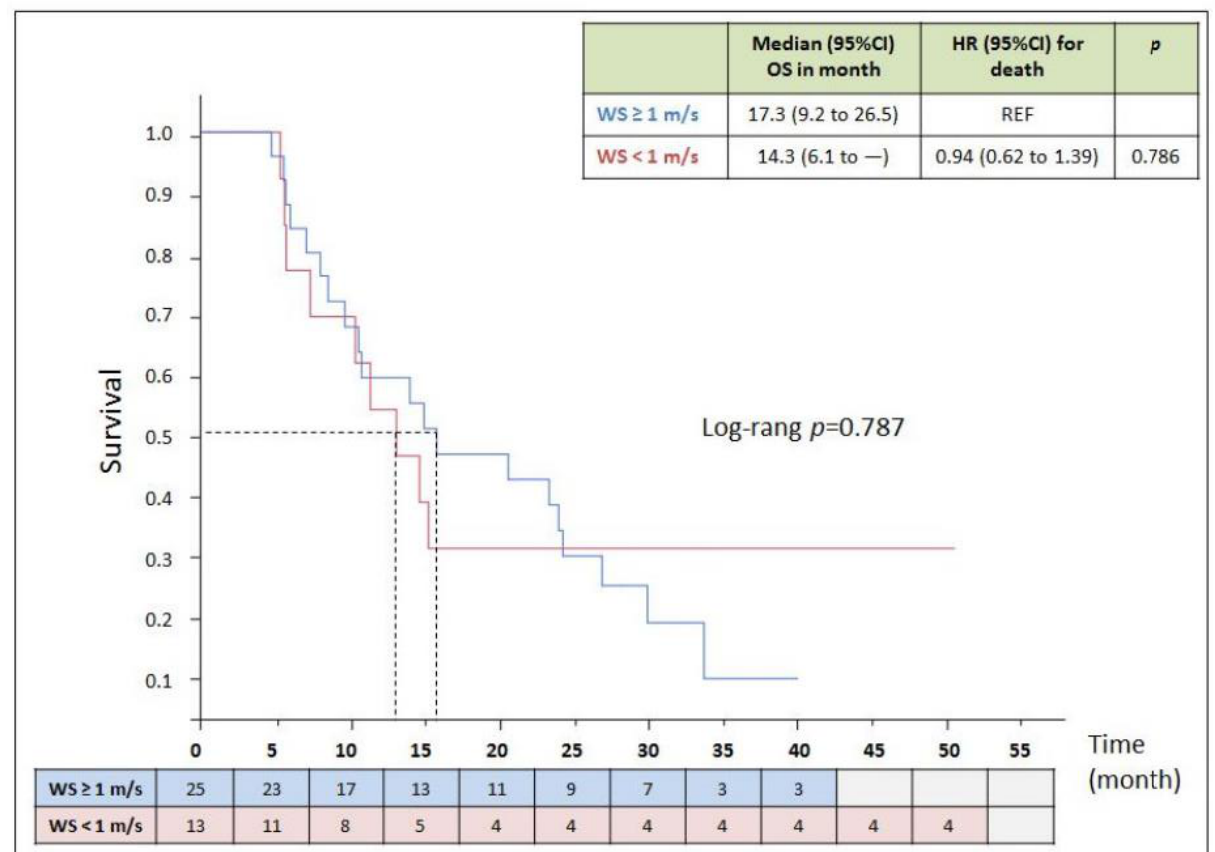
Figure 3. Overall survival according to walking speed ( n = 38) The Kaplan – Meier curves represent the survival over time according to the walking speed (< or ≥ 1 m/s) in participants treated with chemotherapy or immunotherapy. The day of the biopsy was considered as baseline.